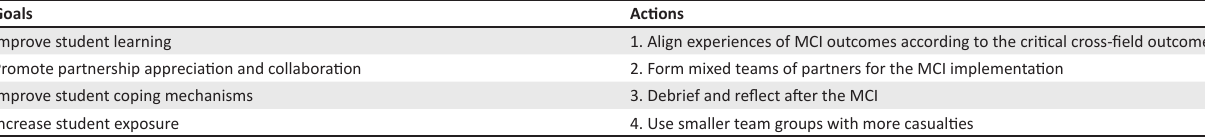
TABLE 2: Goals and the complementary actions of the mass casualty incident.